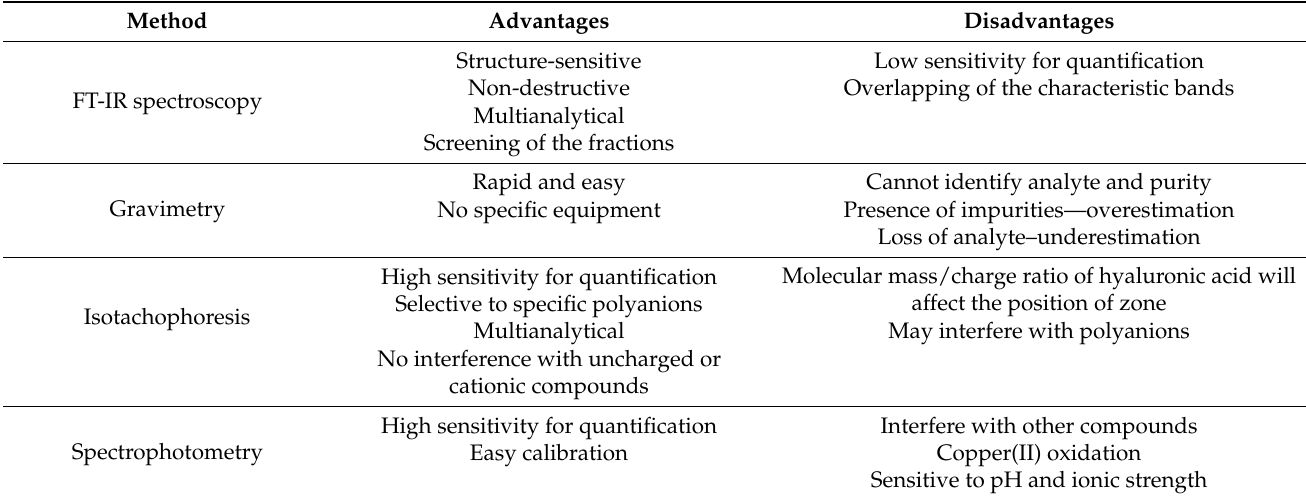
Table 5. Advantages and disadvantages of analytical methods used in the